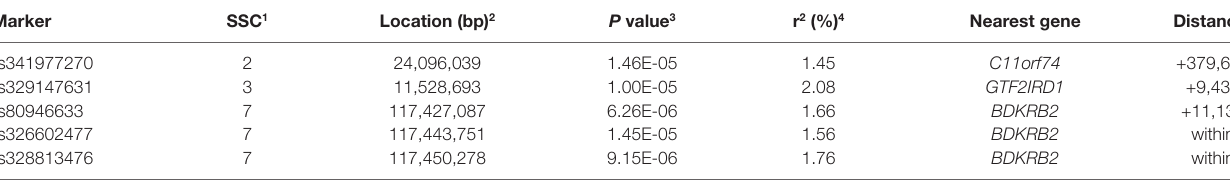
TABLE 2 | Description of significant SNPs identified by MLM as associated with IMF.